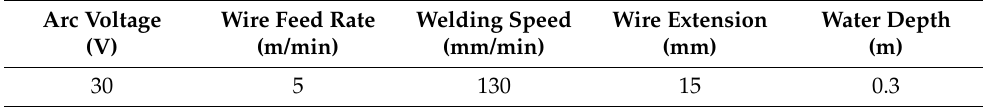
Figure 1. Schematic of underwater submerged-arc welding. Table 3. The specific parameters during welding.